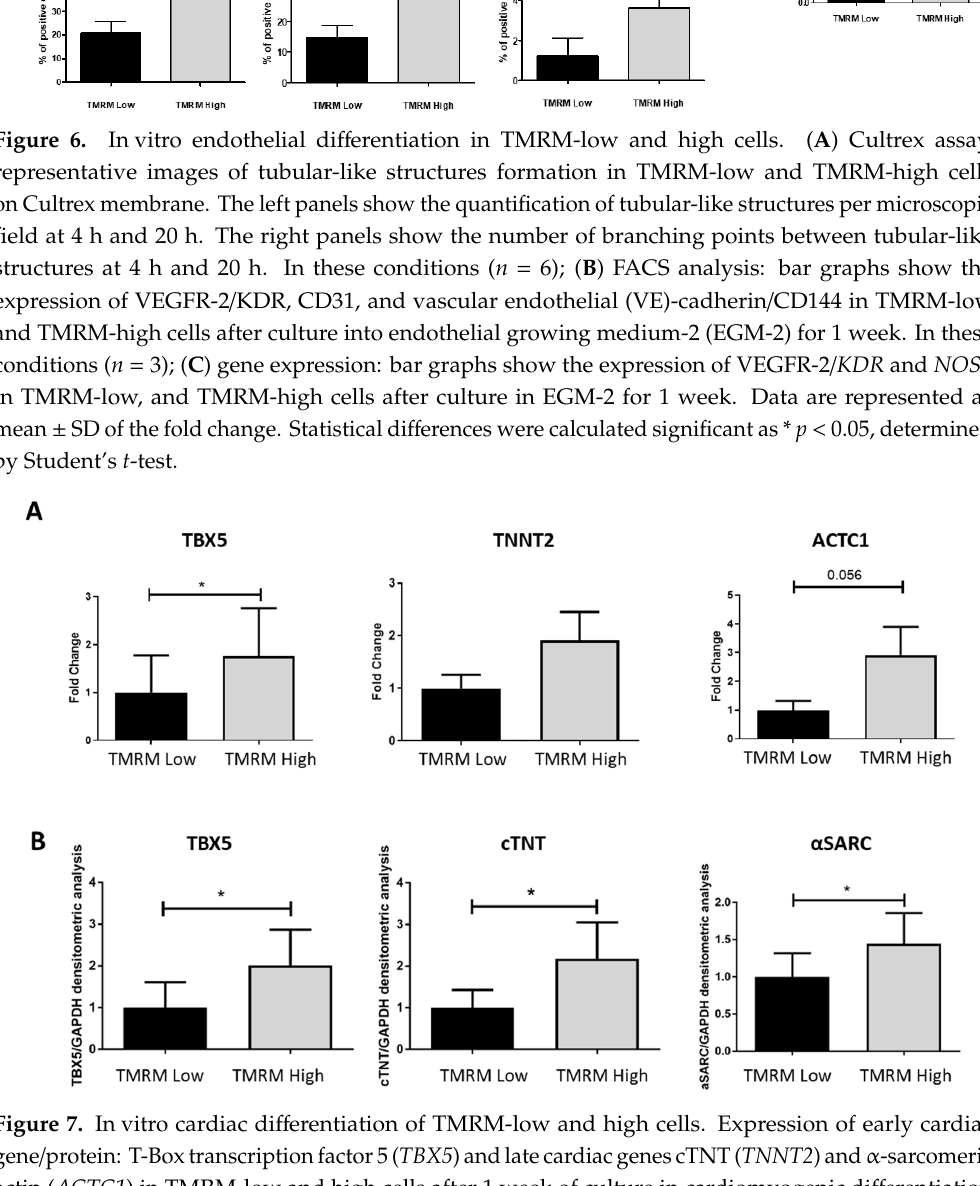
Figure 7 . In vitro cardiac differentiation of TMRM-low and high cells. Expression of early cardiac gene / protein: T-Box transcription factor 5 ( TBX5 ) and late cardiac genes cTNT ( TNNT2 ) and α -sarcomeric actin ( ACTC1 ) in TMRM-low and high cells after 1 week of culture in cardiomyogenic differentiation media. The expression of these genes was analyzed by qRT-PCR ( n = 5) ( A ) , and Western blot ( n = 4) ( B ) Data are represented as mean ± SD of the fold change. Statistical differences were calculated significant as * p < 0.05, determined by paired Student’s t-test.